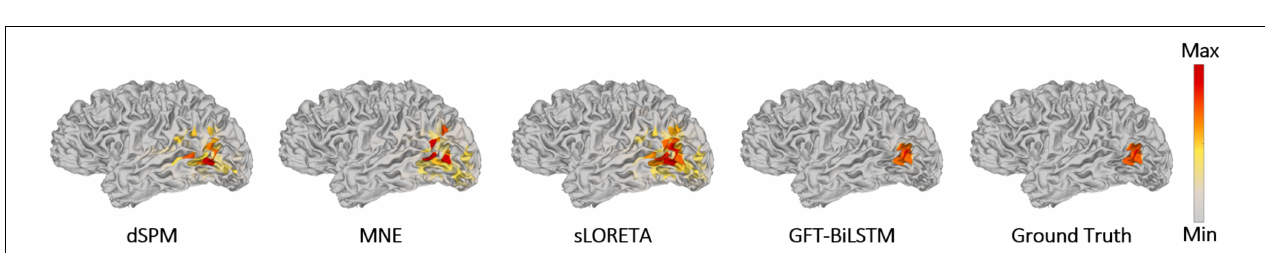
FIGURE 6 | Brain source activations estimated by different ESI algorithms with a single activated